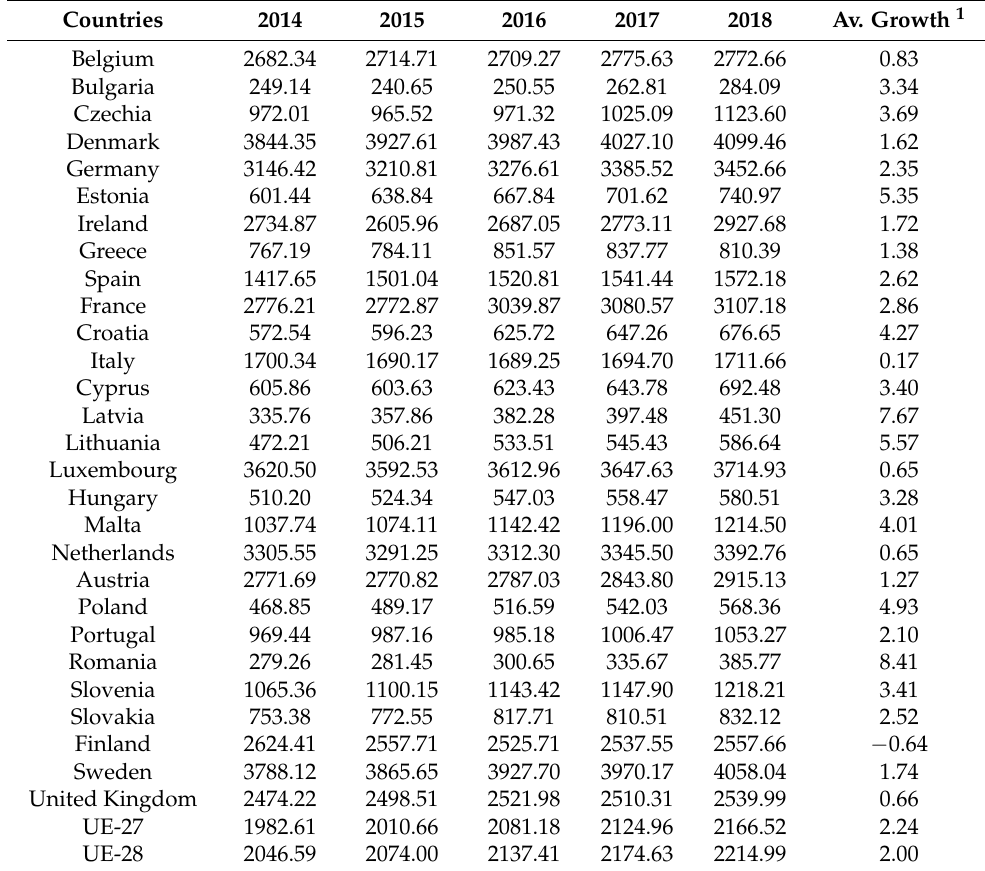
Table 4. Public Spending on Health (PSH) per capita (millions € —2010 constant prices).